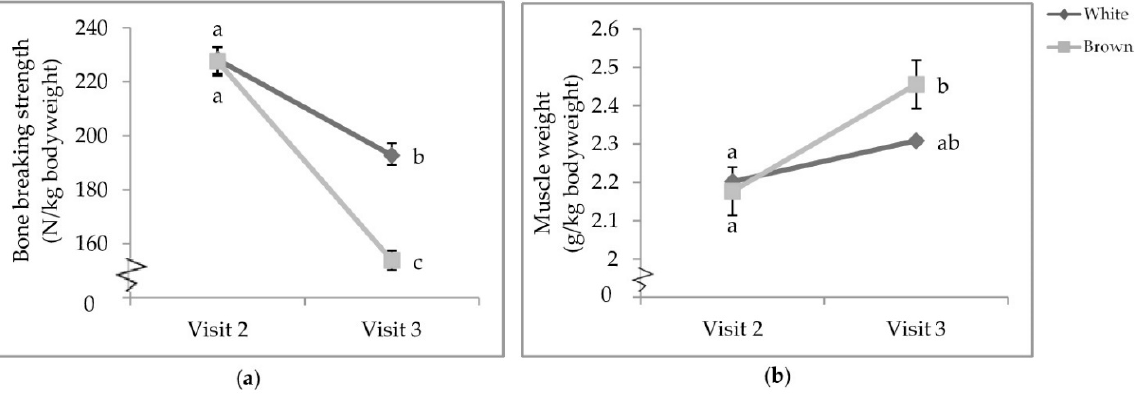
Figure 6. Visit by colour interaction of ( a ) tibia breaking strength; ( b ) bicep weight. Pullets were 68.5 ± 4.94 and 111.5 ± 3.45 days of age, respectively, when euthanised by cervical dislocation during visits two and three. Error bars represent standard error.